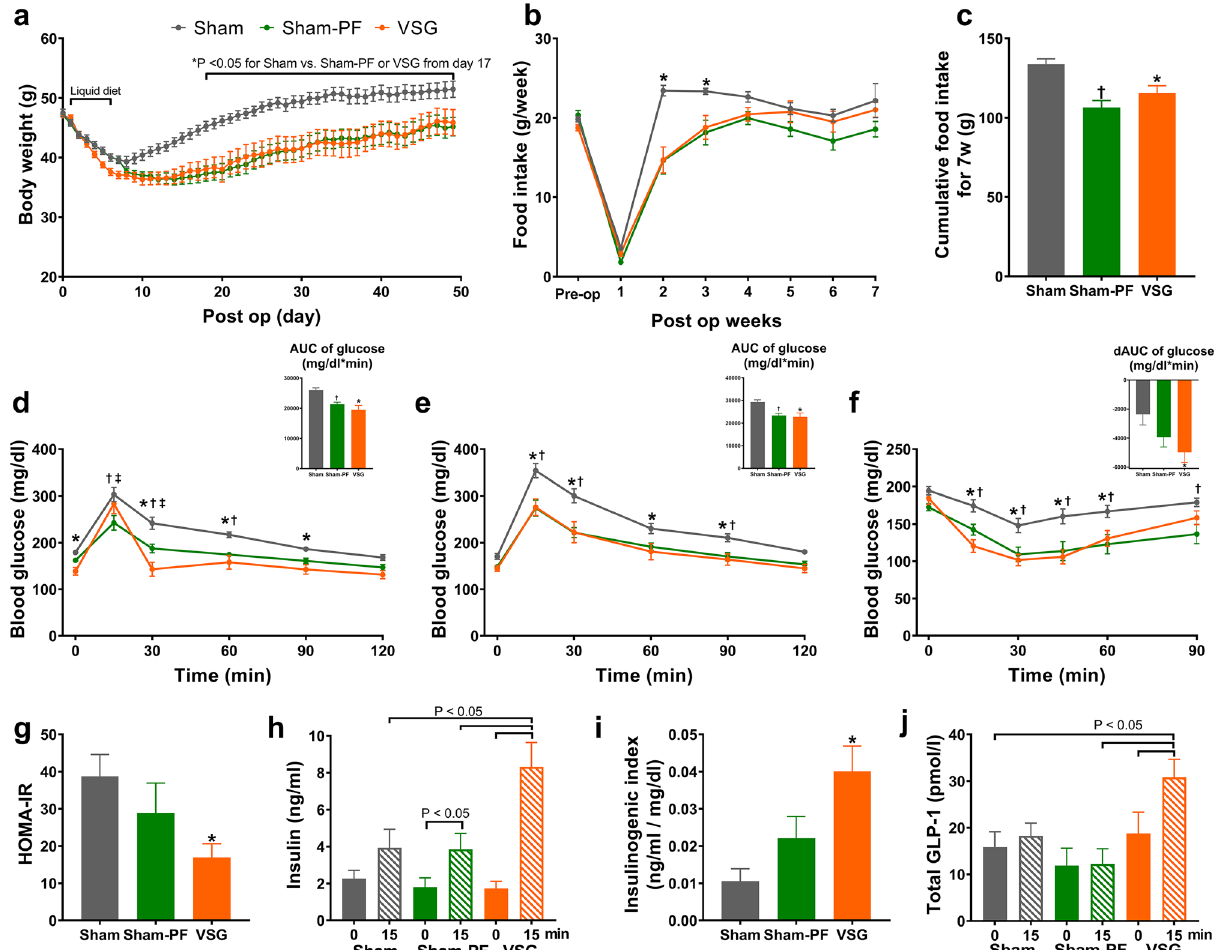
Figure 1. VSG induced sustained weight loss and improved glucose tolerance. ( a ) Body weight, ( b ) weekly food intake and ( c ) cumulative food intake during 7 weeks after surgery. ( d ) Blood glucose levels during the oral glucose tolerance test and the AUC of glucose levels (inset figure). ( e ) Blood glucose levels during the intraperitoneal glucose tolerance test and the AUC of glucose levels (inset figure). ( f ) The blood glucose levels during the insulin tolerance test and the decremental AUC, which is the area under the curve of the glucose levels below the baseline glucose level (inset figure). ( g ) HOMA-IR is defined as fasting glucose level (mg/ dl) × fasting insulin level (μU/ml)/405. ( h ) The plasma insulin levels of fasted and 15 min after the oral glucose challenge. ( i ) Insulinogenic index is the increment of the insulin divided by the increment of the glucose level between fasting and 15 min after the oral glucose challenge. ( j ) The plasma GLP-1 levels of fasted and 15 min after the oral glucose challenge. N = 12 in each group. Comparison: Repeated measured ANOVA with Sidak’s post hoc test. * P < 0.05 for sham versus VSG. Data are mean with SEM. † P < 0.05 for sham versus sham-PF. ‡ P < 0.05 for sham-PF versus